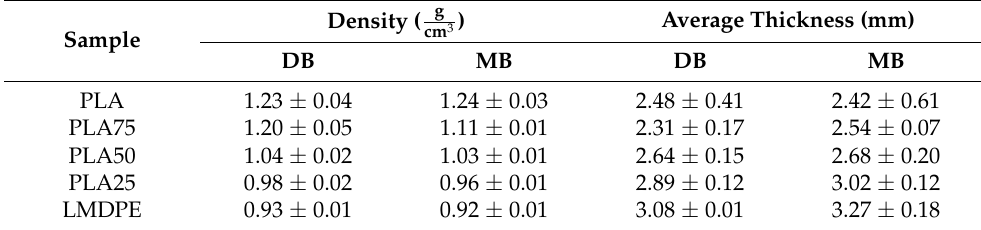
Figure 2. IAT (internal air temperature) profiles ( a ), as well as their first ( b ) and second ( c ) derivatives as a function of time for PLA, LMDPE, and their blends prepared by dry blending (DB). Table 3. Experimental measured density and average thickness of the rotomolded